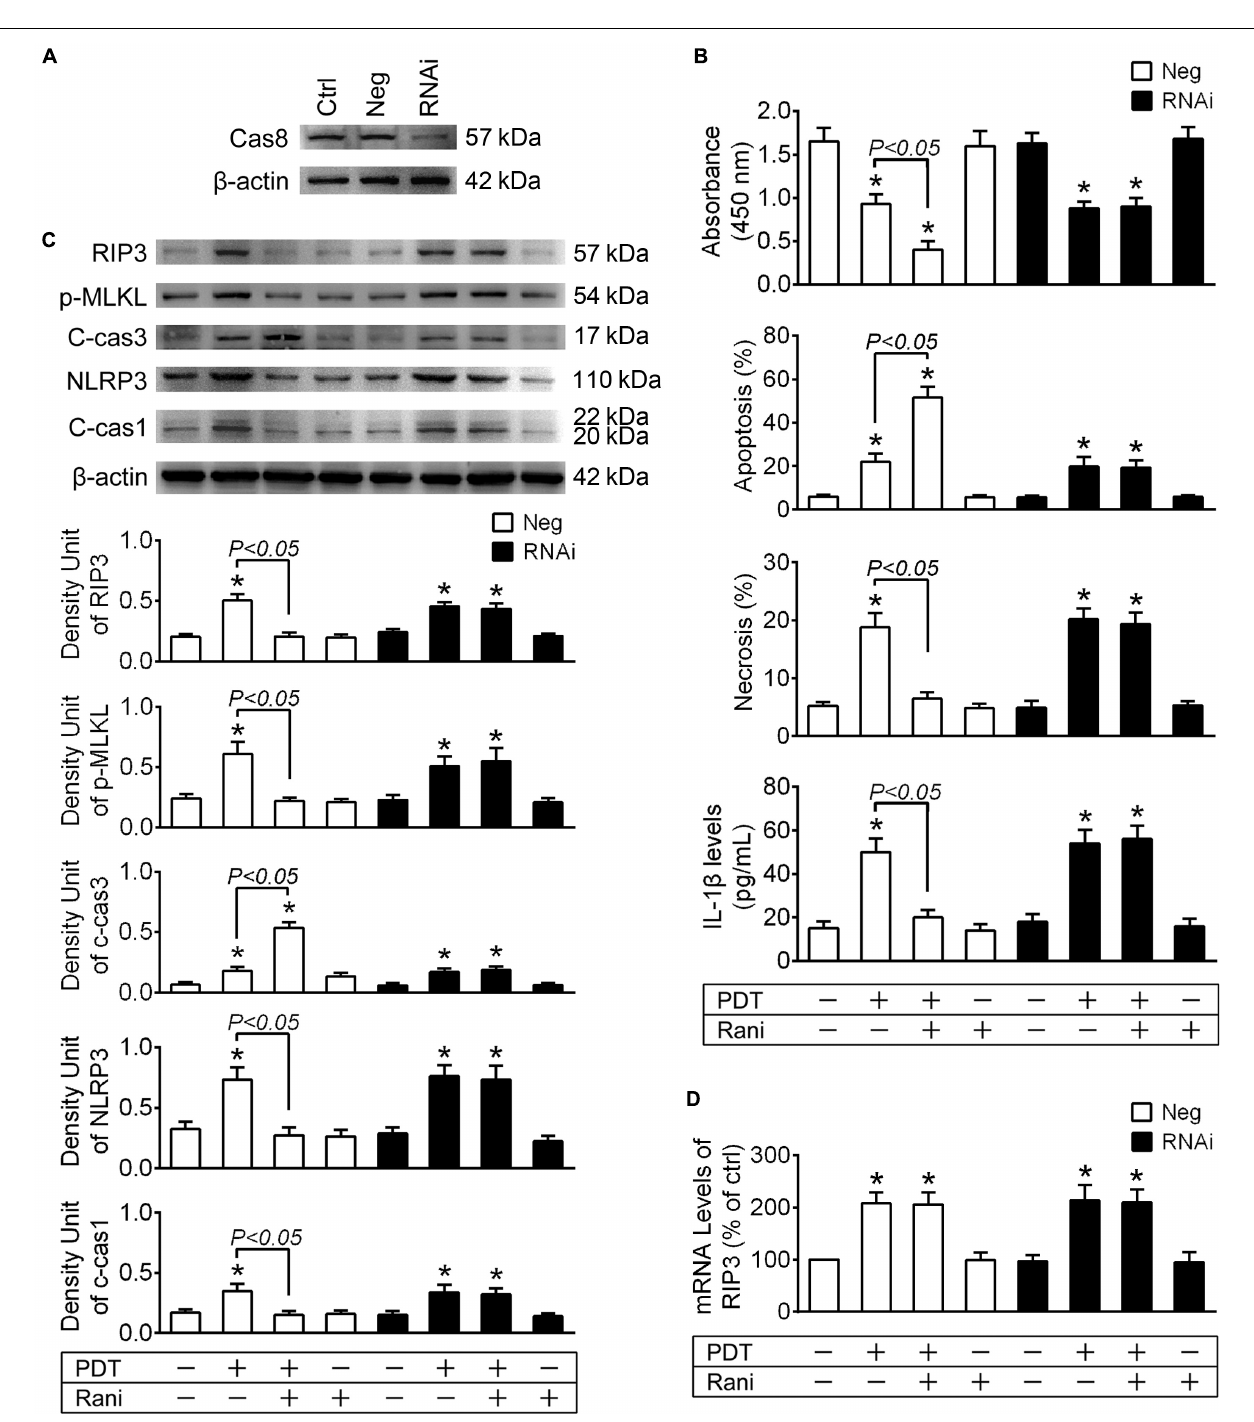
FIGURE 4 | Cas8 knockdown abolishes rani’s function of suppressing RIP3 upregulation and its downstream events in PDT-exposed cells. (A) RF/6A cells were transfected with cas8 siRNA (RNAi group) or a negative control sequence (Neg group), and the expression of cas8 was assayed by immunoblotting at 2-day after transfection. (B) After cas8 knockdown for 2-day, RF/6A cells were exposed to PDT, and rani was applied to the cells at 6 h before PDT. Cell viability was measured with CCK-8 at 12 h after PDT, while cell apoptosis and necrosis were determined by flow cytometry, and IL-1 β protein levels in cell culture medium were detected using a monkey IL-1 β ELISA kit. (C) Meanwhile, the protein levels of RIP3, p-MLKL, c-cas3, NLRP3 and c-cas1 in RF/6A cells were detected by immnoblotting. (D) The mRNA levels of RIP3 were measured by real-time PCR analysis. n = 4; * P < 0.05, compared with the control.